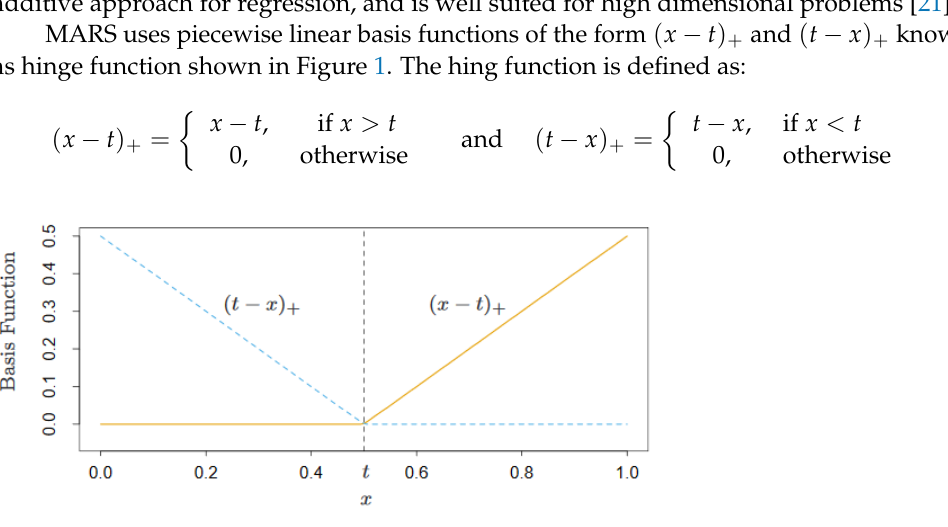
Figure 1. The basis functions ( x − t ) + (solid orange) and ( t − x ) + (broken blue used by